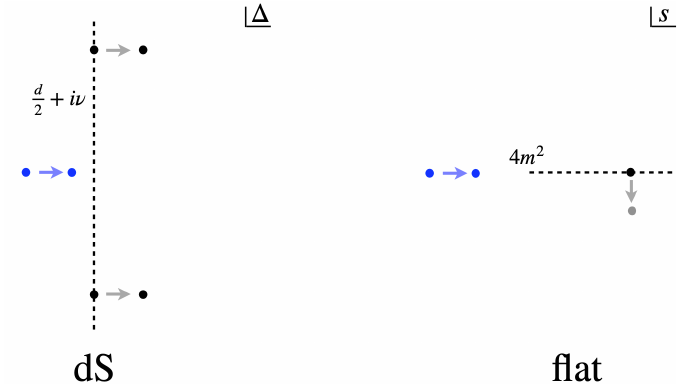
Figure 10 . Left : poles in the spectral amplitude f J for the late-time four-point function. An exchange of a heavy particle produces a pair of poles (the black dots) on the principal series Re∆ = d (the dashed line) at tree level. At finite coupling, they move off the principal series to the right and become resonance. On the other hand, a light particle gives a pole (the blue dot) in the region, Re∆ < d and Im∆ = 0 , corresponding to the complementary series. Such a pole will continue to 2 remain in the complementary series even after turning on the interaction weakly. Right : analogous features in the partial wave amplitude in flat space. A pole on the two-particle branch cut (the black dot) moves to the second sheet after turning on the interaction while a pole below the threshold (the blue dot) is stable even after turning on the interaction